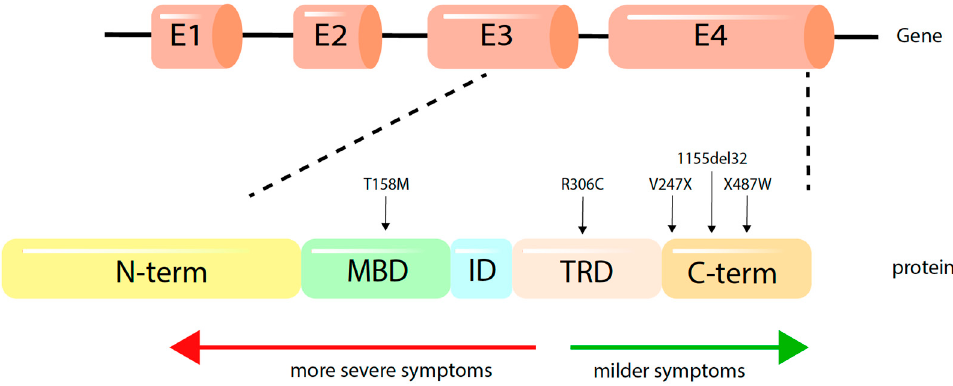
Figure 1. Source of RNA-sequencing datasets, sequencing platform and methodology of data analysis using Weighted Gene Correlation Network analyses (WGCNA) to identify relevant modules of genes and subsequent preservation analysis between studies.